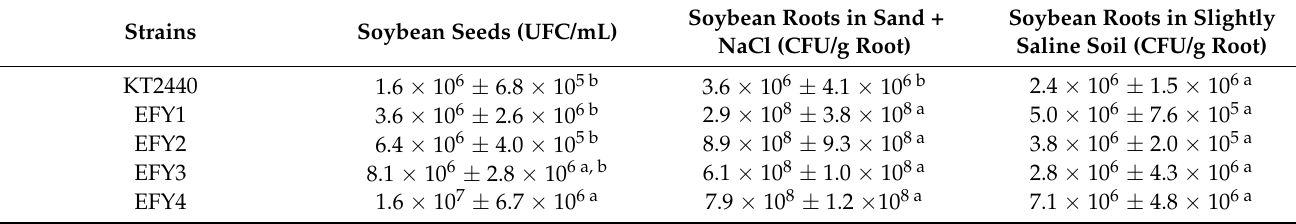
Data express mean ± standard deviation values of four independent trials. Values within columns followed by different letters indicate significant differences among the strains in each condition ( p < 0.05, Tukey’s